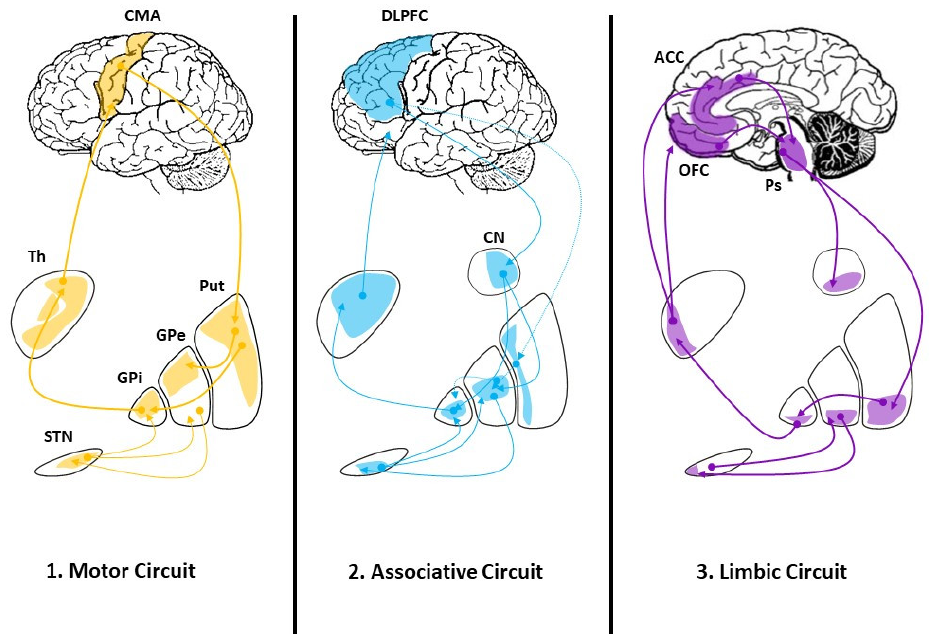
Figure 1. Schematic diagram of the main functional division of the cortico-basal ganglia connections sub-divided according to the main cortical projection areas. ( 1 ). The motor circuit: cortical motor areas. ( 2 ). The associative circuit: dorsolateral prefrontal cortex. ( 3 ). The limbic circuit: orbitofrontal cortex and anterior cingulate cortex (modified from Obeso et al. [45]). CMA: cortical motor areas; Th: thalamus; Put: putamen; GPe: globus pallidus pars externa; GPi: globus pallidus pars interna; STN: subthalamic nucleus; DLPFC: dorsolateral prefrontal cortex; CN: caudate nucleus; ACC: anterior cingulate cortex; OFC: orbitofrontal cortex, Ps: pons.